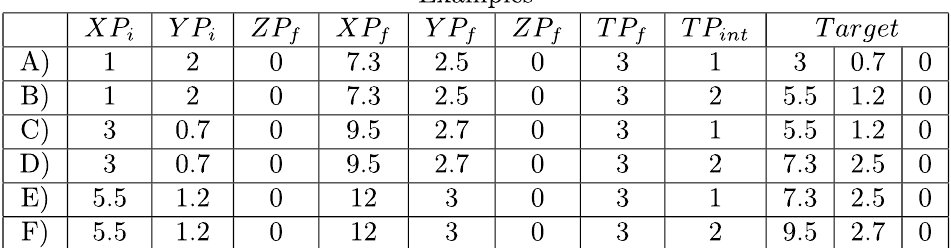
Figure 2. ( A – D , F ) are examples and each gray circle is a position. A is the first example that has P i = P 1 , P f = P 4 and Target = P 2 . Then, in B, a shift is made on the Target. As there are no more possibilities to build an example with this window, due to the target having passed through all the points between P i and P f , then it slides to the right, that is, P i = P 2 , P f = P 5 and Target = P 3 , in this way example C is created. The process continues until it is no longer possible to create new